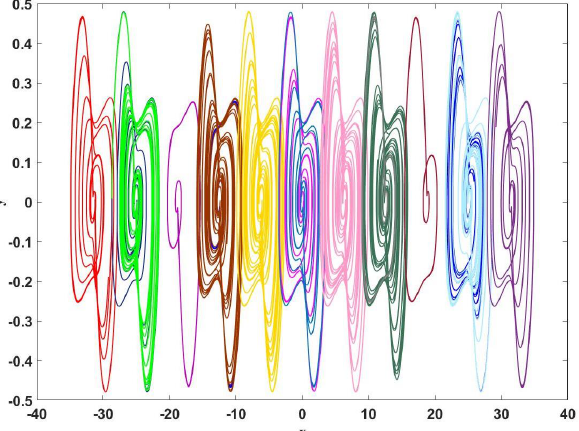
Figure 2. Phase portrait trajectory of infinitely coexisting attractors for the fractional order q = 0.98 and initial conditions ( x 0 , 0, 0, 0) with x 0 varying between − 30 and + 30 for an increment of 5. We can notice the existence of several periodic attractors with chaotic